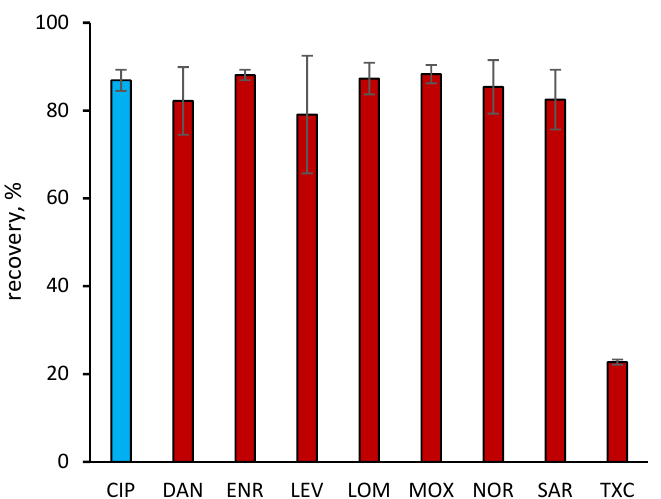
Figure 5. Selectivity after loading of 1 mL of synthetic urine containing 200 ng mL − 1 of analyte, diluted 9 + 1 v / v with 50 mmol L − 1 MES buffer, pH 4.5.